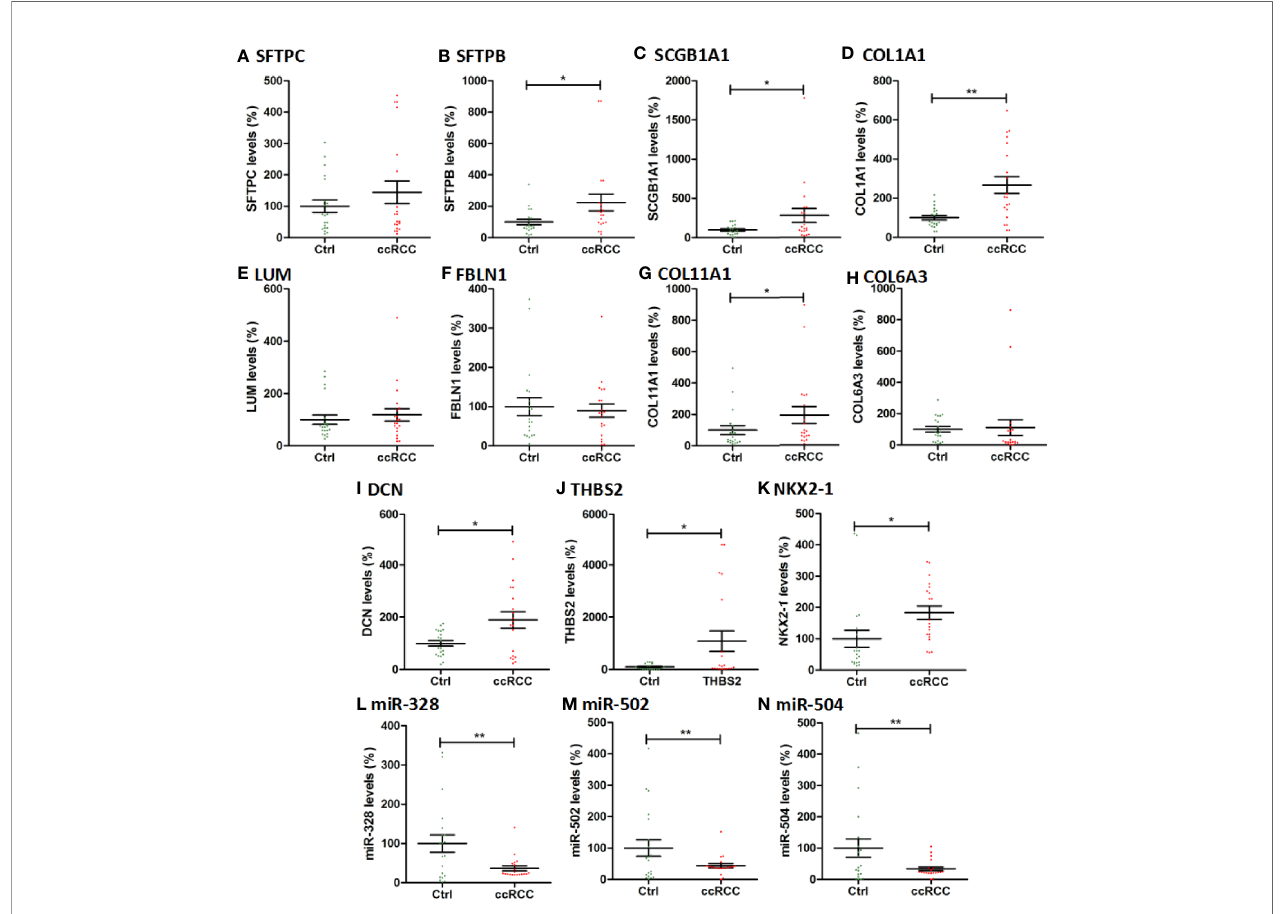
FIGURE 7 | The qPCR results of 11 hub genes and 3 key miRNAs in 20 ccRCC tissues and paired adjacent normal kidney tissues. The vertical coordinate represents the expression levels of genes and miRNAs. Ctrl: Paracancer tissues. * indicates P<0.05; ** indicates